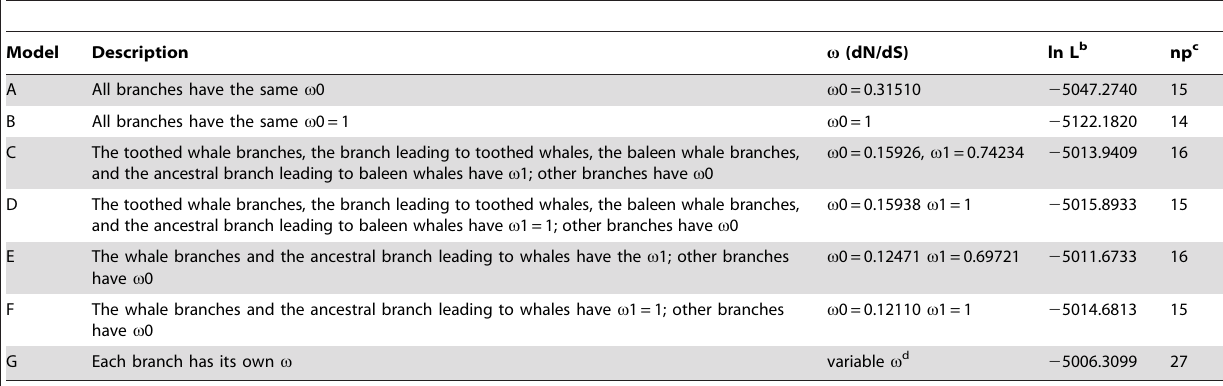
Table 4. Models and parameter estimates for likelihood ratio tests of selective pressure on whale MOXD2 gene a .